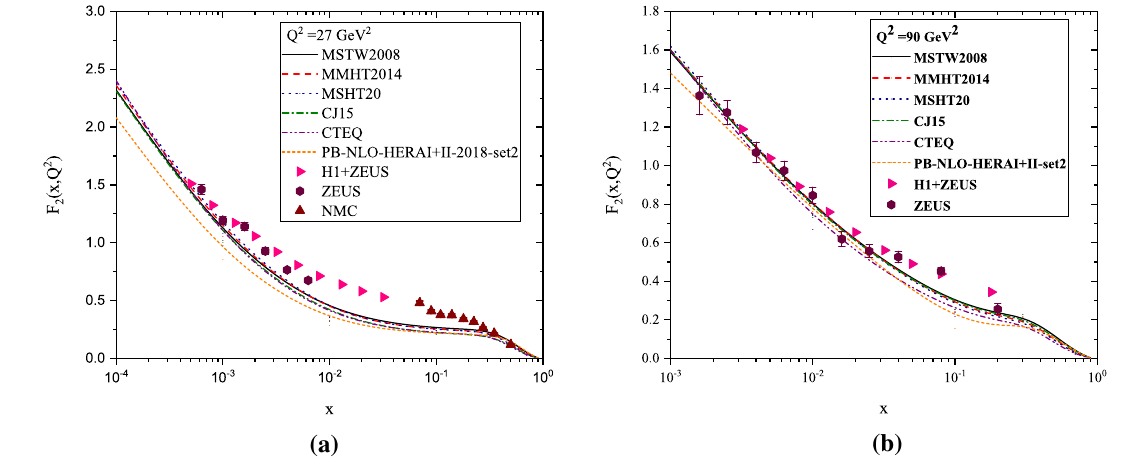
Fig. 8 Compare the structure function for numerous sets of PDFs with experimental data in the scale a Q 2 = 27 GeV 2 and b Q 2 = 90 GeV